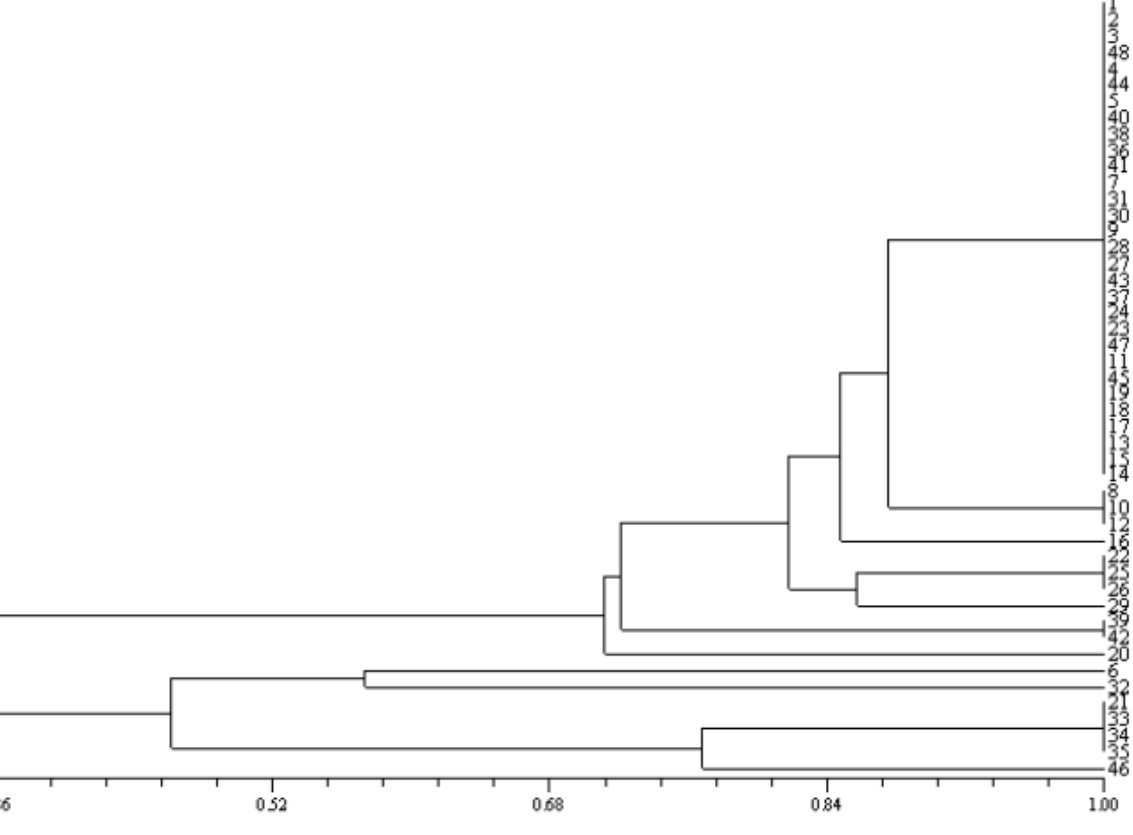
Figure 1. Dendrogram for phenotypic characteristics of 48 isolates among ice cream samples based on the UPGMA algorithm of utilized carbon sources. Phenon 1 (1–16), Phenon 2 (22–29), Phenon 3 (39–42), Phenon 4 (2), Phenon 5 (6), Phenon 6 (32), Phenon 7 (21–35), and Phenon 8 (46).